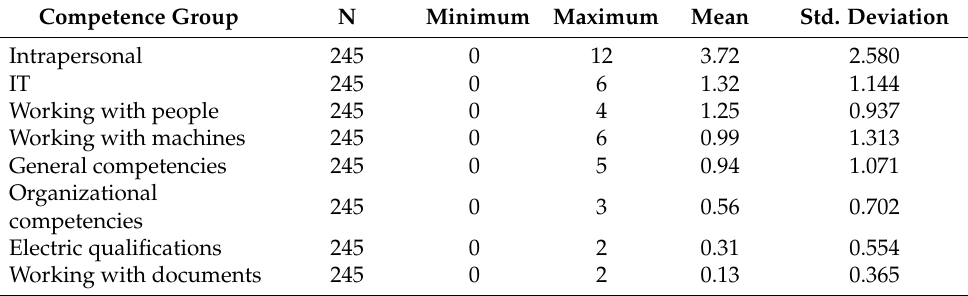
Table 11. Indications of competencies within the groups. Descriptive